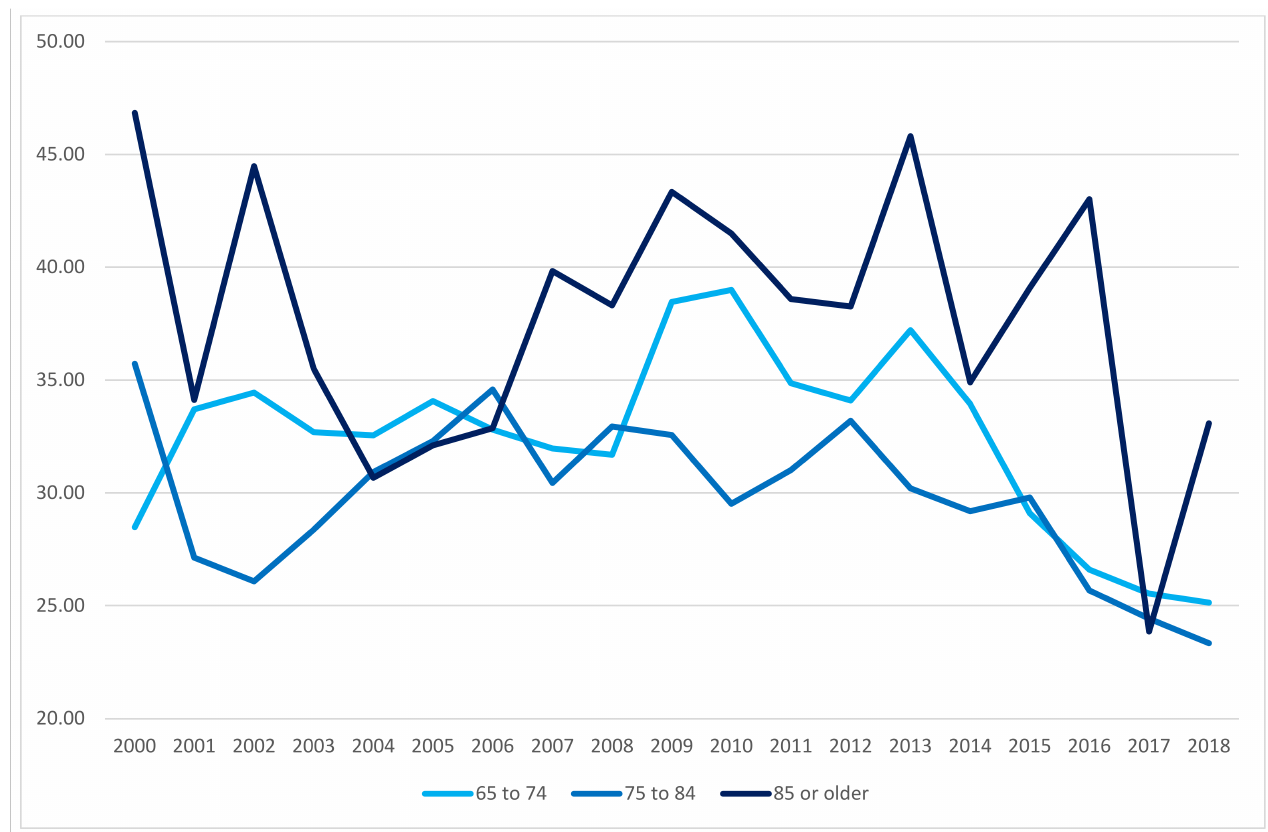
Figure 1. Suicide rates (per 100,000 population) among male adults aged 65 or older by age group from 2000 to 2018. Source: Polish Central Statistical Office